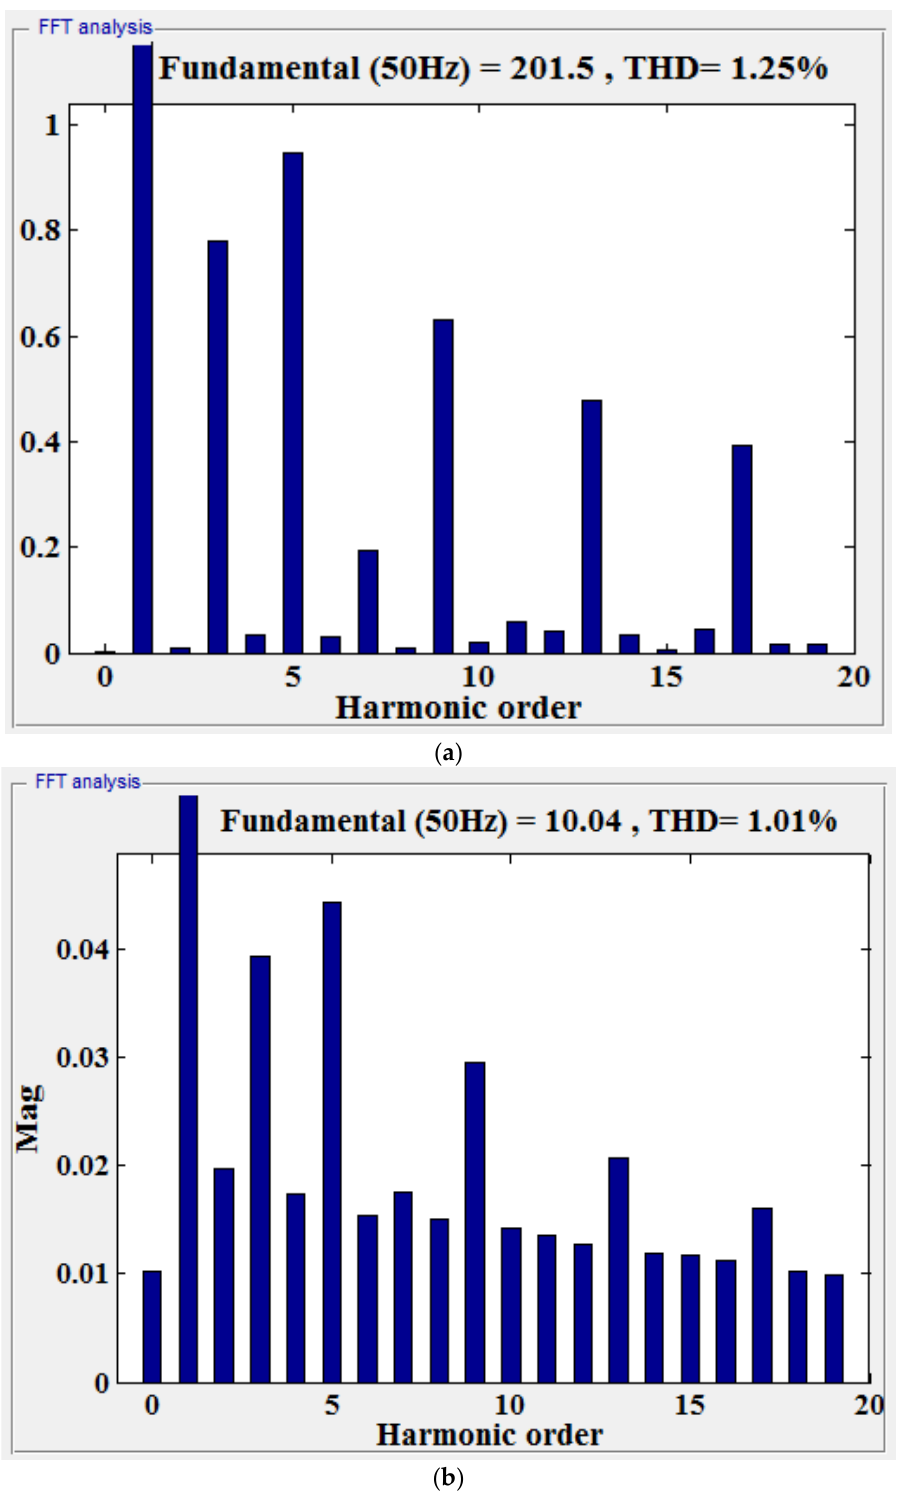
Figure 9. ( a ) FFT for output voltage fed with RL load; ( b ) FFT for output current fed with RL load.